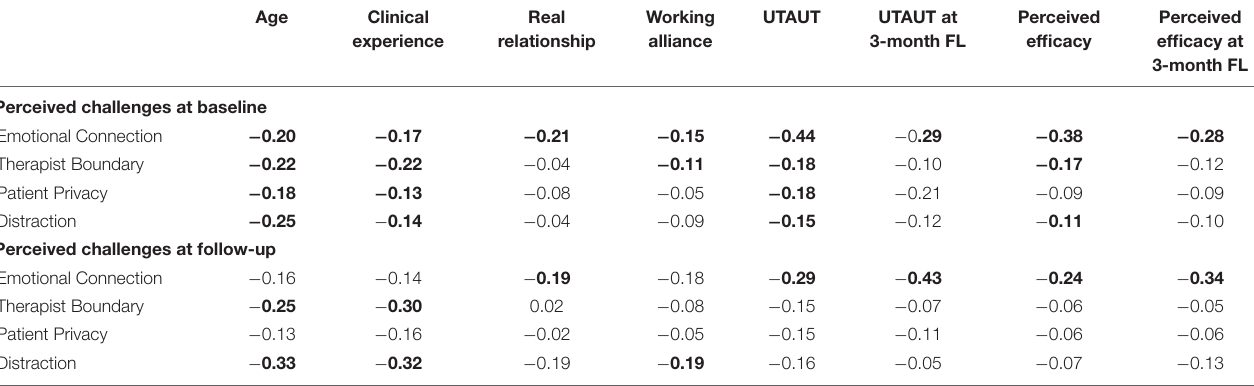
TABLE 4 | Pearson correlations between categories of perceived challenges, demographic variables, therapeutic relationship, and attitudes and perceived efficacy of online therapy at baseline and 3-month follow-up.